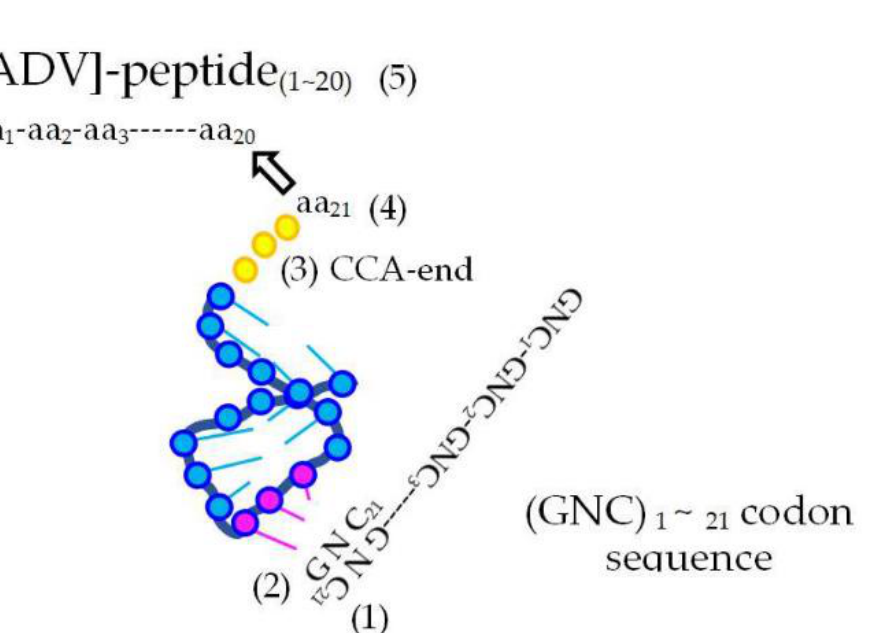
Figure 5. Elements involved in genetic code. (1) Codon on a (GNC) n mRNA sequence. (2) Anticodon carried by primitive AntiC-SL tRNA. (3) CCA-end. (4) One of [GADV]-amino acids bound with 5- (cid:48) CCA-3 (cid:48) end of AntiC-SL tRNA. (5) Elongating oligo-[GADV]-peptide.